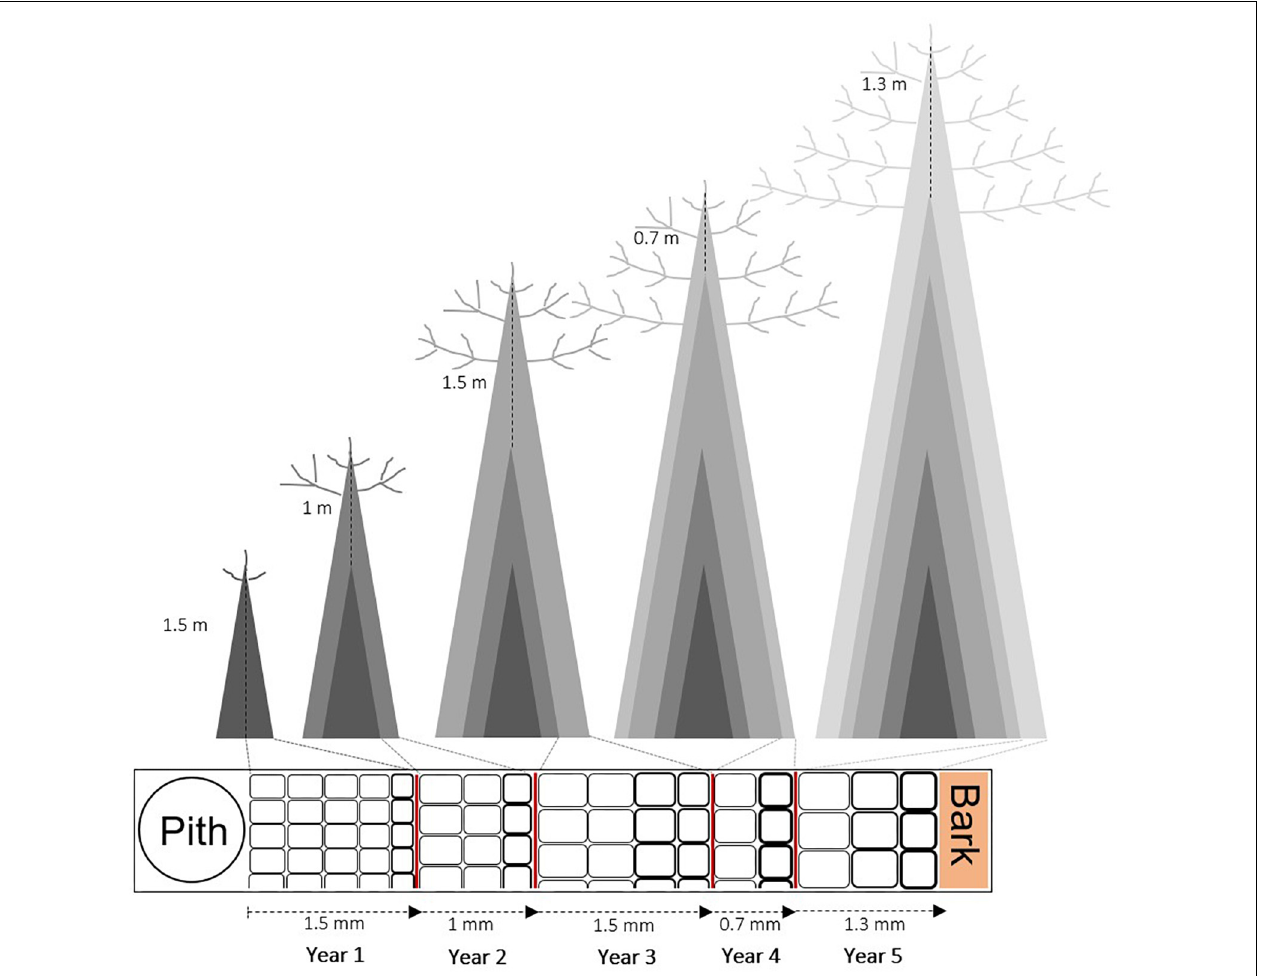
FIGURE 1 | Sketch of the wood structure scaling from pith-to-bark in relation to tree height (modified from Rosell et al., 2017) in a hypothetical 5-years-old tree, supposing the same radial (tree-ring width) and longitudinal (internode length) growth. The change in number and size of tracheids is shown from pith to bark. There are more and smaller tracheids in short trees (or close to the pith), and fewer and wider tracheids in tall trees (or close to the bark) compared to the previously formed ring.